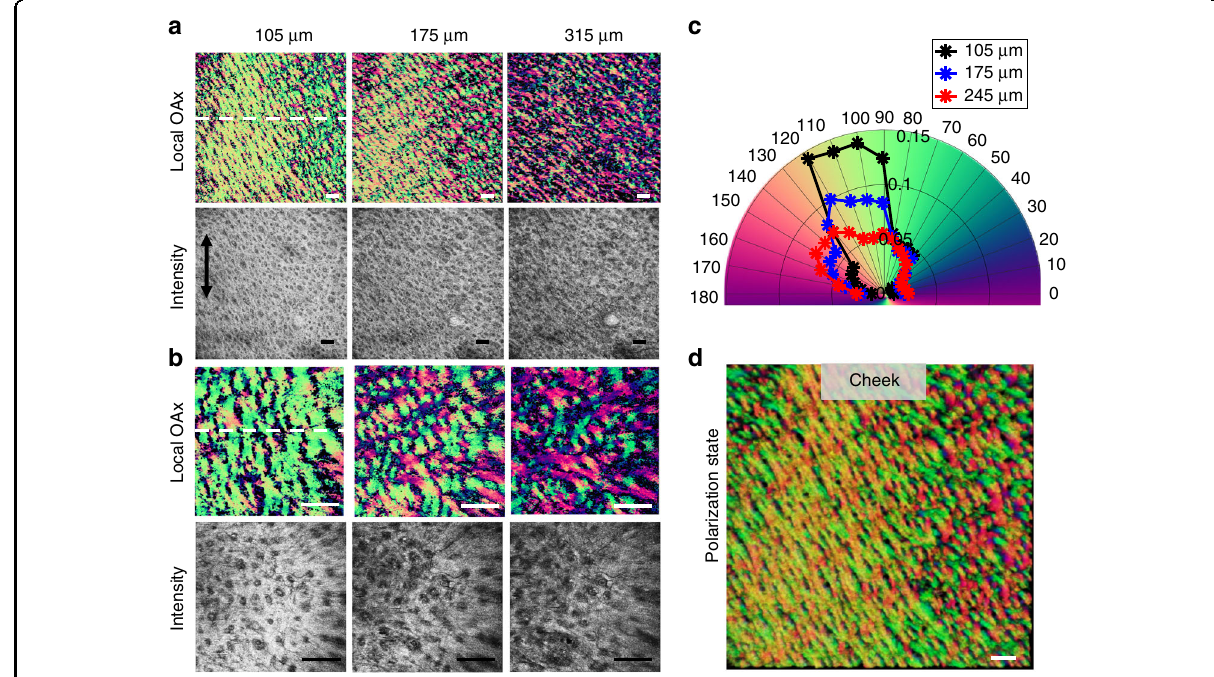
Fig. 4 Depth-resolved collagen organizations within the cheek skin. Depth-resolved collagen fi ber orientations within facial skin are revealed by PSOCT images. Results shown are obtained from a selected region of cheek skin (marked as red square in Fig. 3a). a, b The en-face local optical axis orientation (OAx) images and the corresponding en-face OCT intensity images at three different depths (105, 175, and 245 μ m) using high and low lateral resolution scanning probe, respectively; Black double-headed arrow shows the direction of the body axis. c The histogram distributions of orientation obtained from the en-face OAx slices shown in a (105, 175, and 245 μ m, respectively). d 3D polarization state image. The scale bar = 500 μ m. The yellow arrow indicates the B-scan direction, which is de fi ned as the 0°. Please also see the PSOCT movies showing axis orientations at all depths: cheek (LSM 03).mov and cheek (LSM